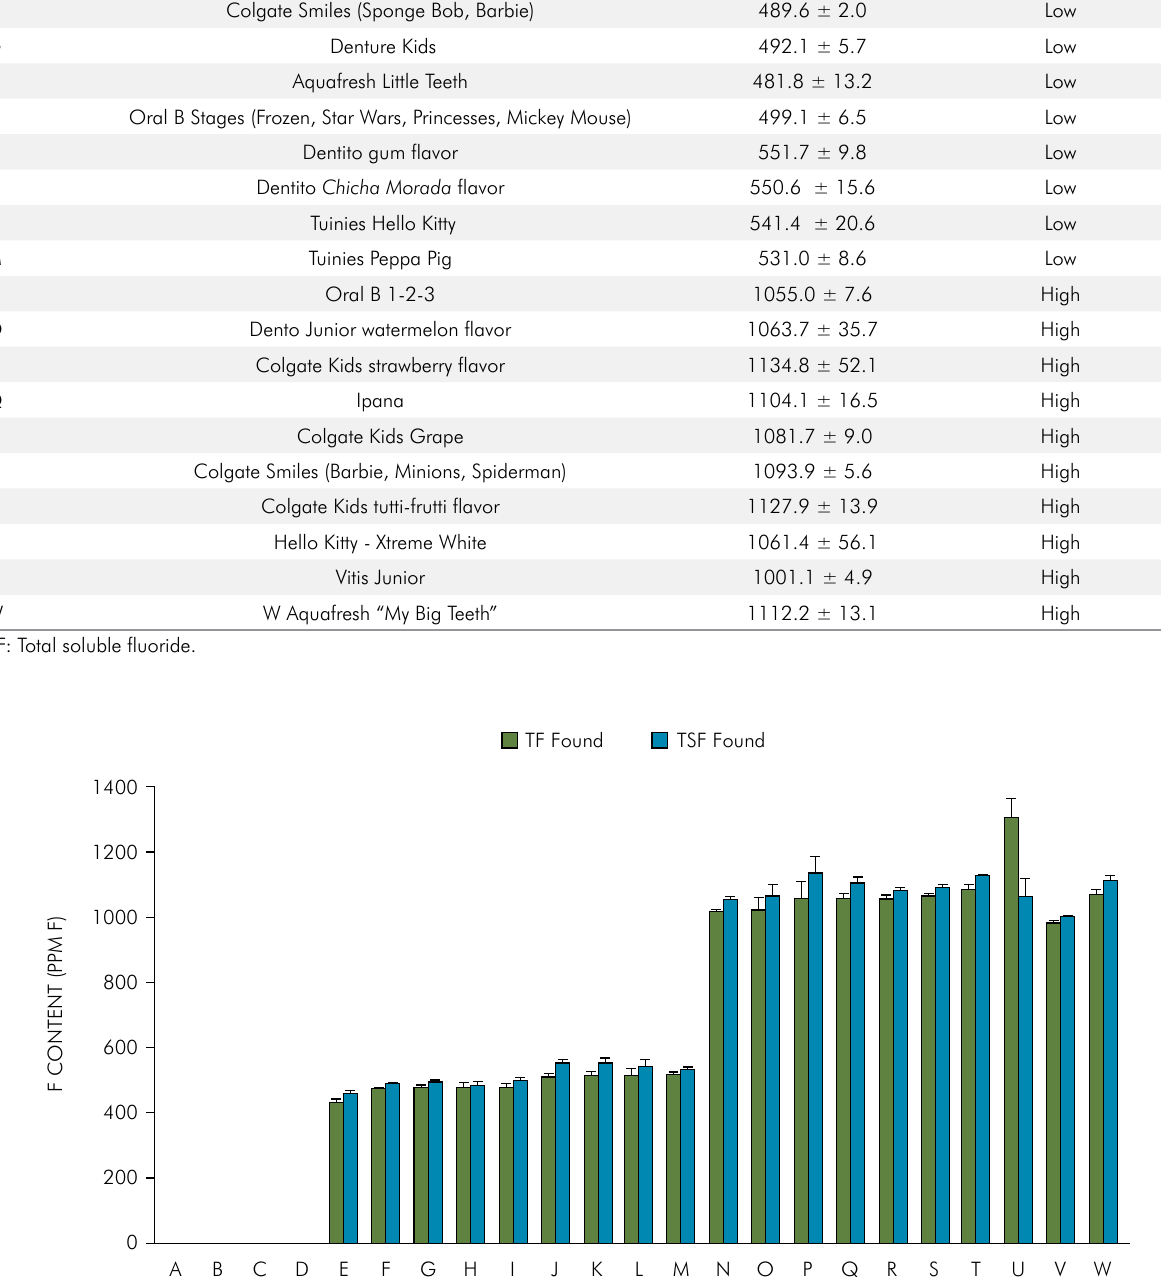
Figure 3. Concentration (ppm F) of total fluoride (TF found) and total soluble fluoride found (TSF found) in the toothpastes analyzed.